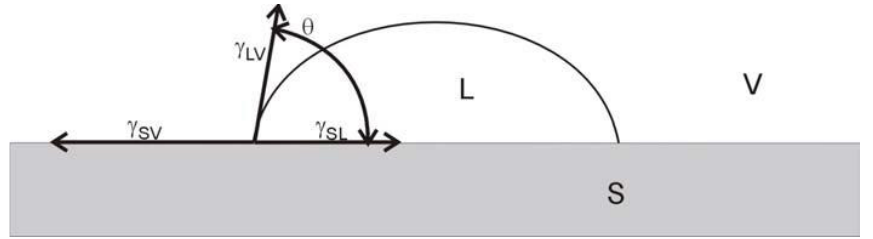
Figure 2. A diagram of the measured values within the droplet .